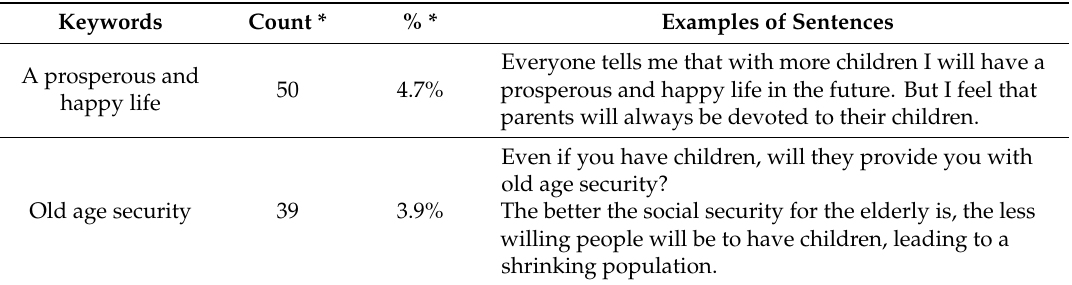
Table 2. Keywords indicating economic benefits and sentence examples.